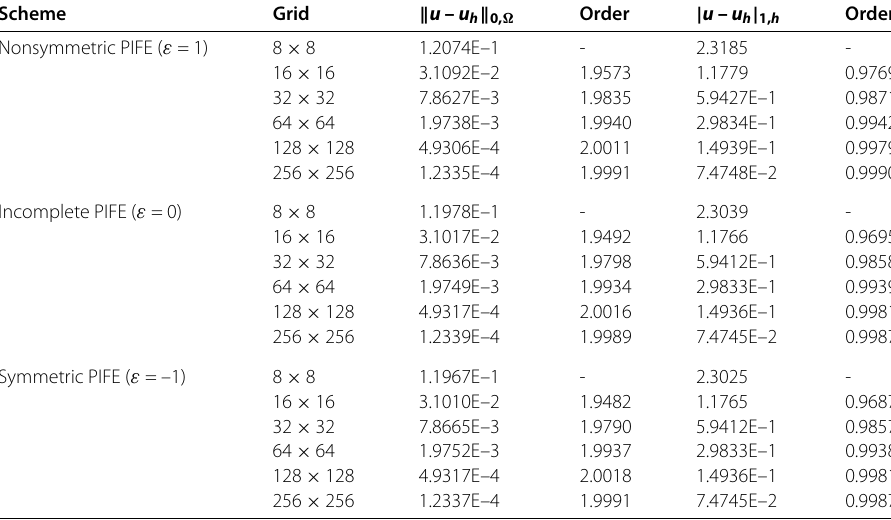
Table 7 Numerical results for B + = [1,2;2,5], B – = [1,000,2,000;2,000,5,000]